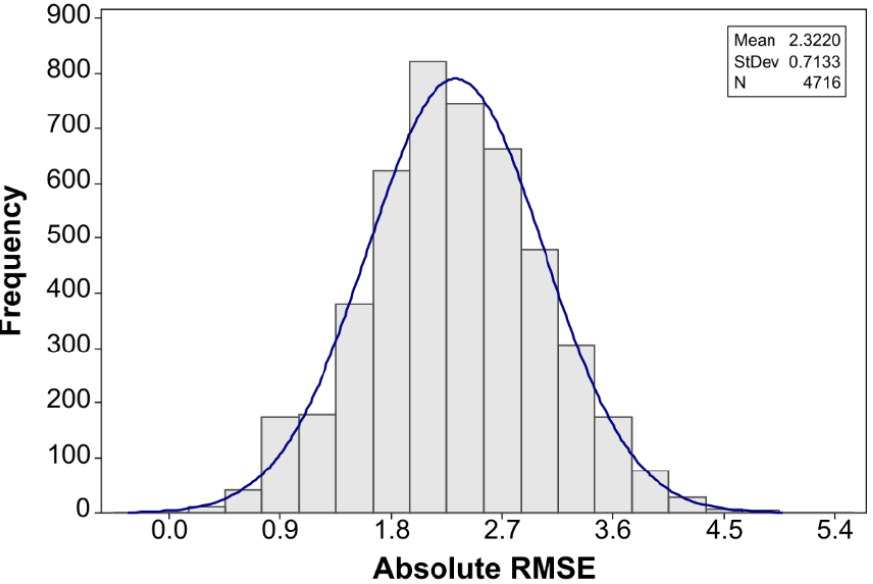
Figure A2. Normal distribution of the root-mean squared error of virtual level measurements. The meaning of the presented statistics denotes that reported measures may have a maximum error (RMSE) of ± 2.32 ± 0.72 mm. Thus, the measurement approach can be assumed as reliable to be employed in similar problems since the previous indications were considered prior image processing. It is important to mention that the employed approach takes advantage of the built-in functions of a commercial software (NI Vision), but all the steps are possible to be ported in an open-source software such as ImageJ or an object- oriented programming language such as JAVA or Python through the OpenCV